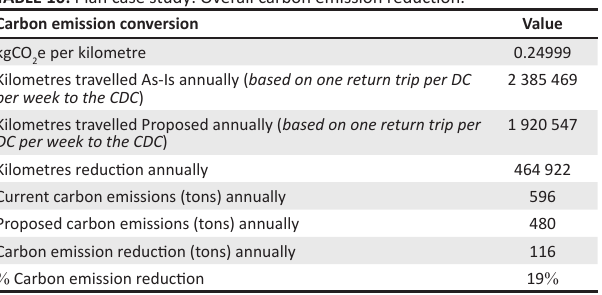
TABLE 10: Plan case study: Overall carbon emission reduction. Carbon emission conversion